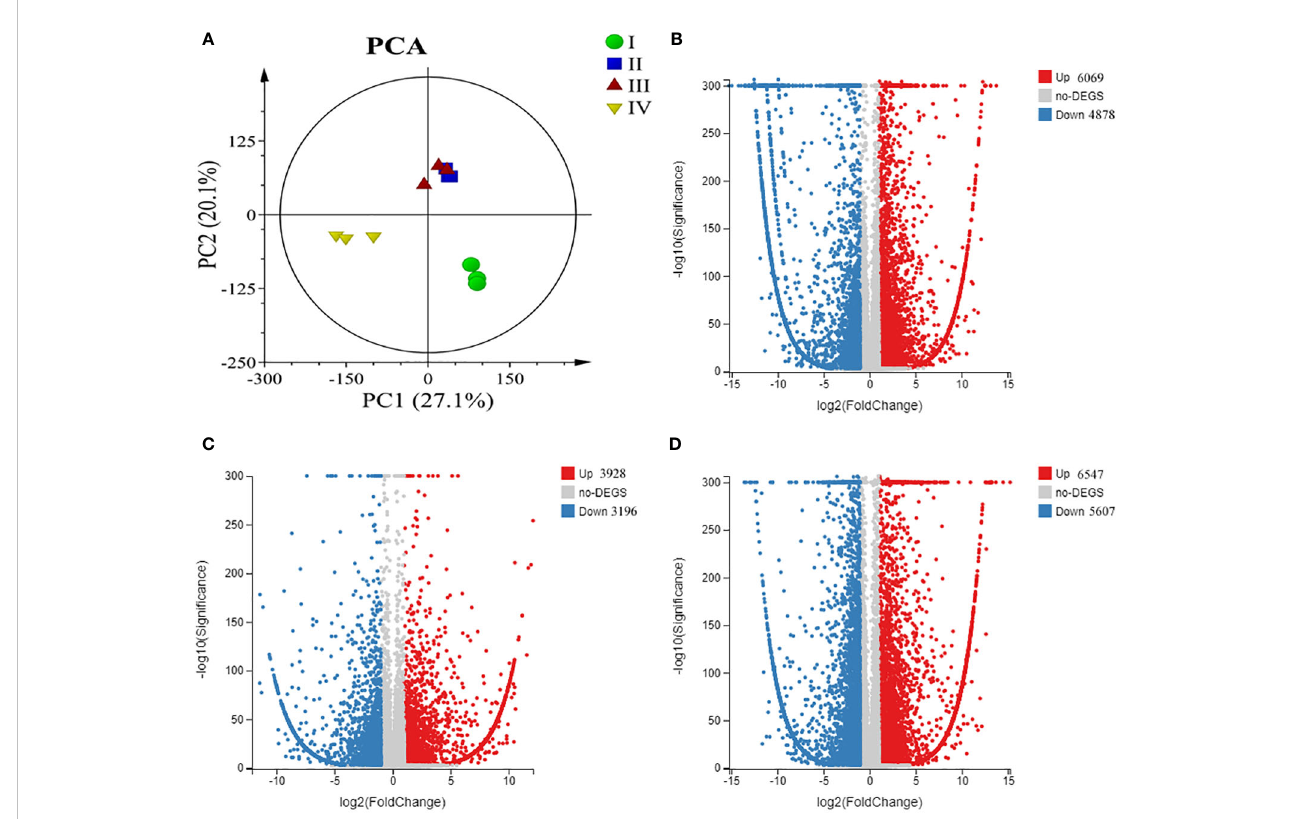
FIGURE 4 Overview of transcriptome changes in tetraspore formation of G. lemaneiformis. (A) Principle component analysis (PCA) of transcriptome of G. lemaneiformis ; (B) Volcano map of differentially expressed genes (DEGs) between Phase I and Phase II; (C) Volcano map of DEGs between Phase II and Phase III; (D) Volcano map of DEGs between Phase III and Phase